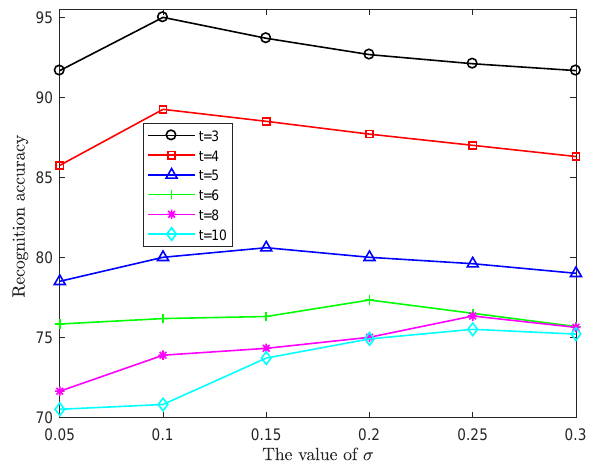
Figure 7. Effect of parameter σ on classification accuracy of